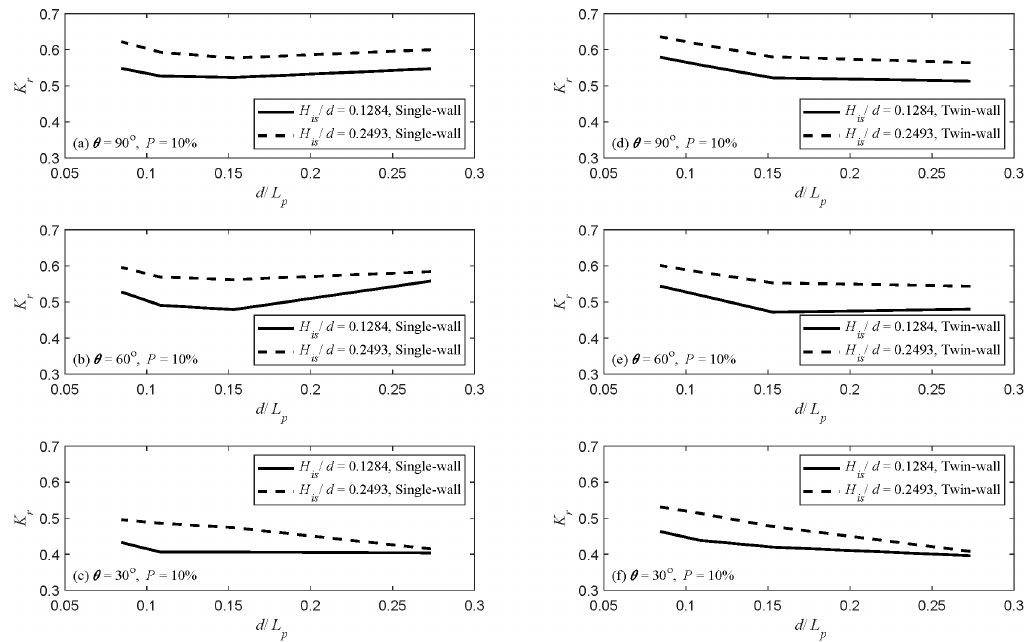
Figure 19. Effect of H is / d on K r for P = 10% and different wall slopes. Subfigures ( a ), ( b ), and ( c ) are for single-wall, and subfigures ( d ), ( e ), and ( f ) are for twin-wall.